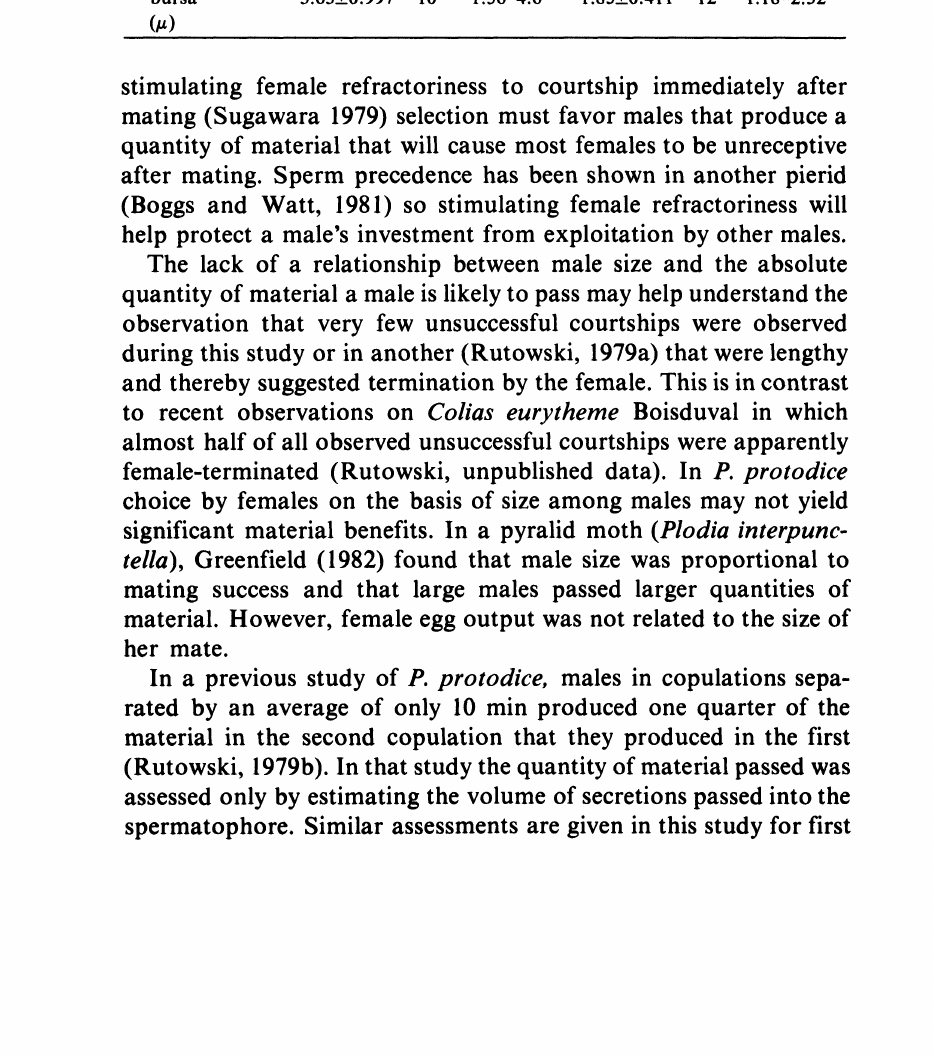
Table 2. A comparison of the performance of males in matings separated by 24 hours. See text for details. First copulation Second copulation Parameter (units) X+SD N Range X+SD N